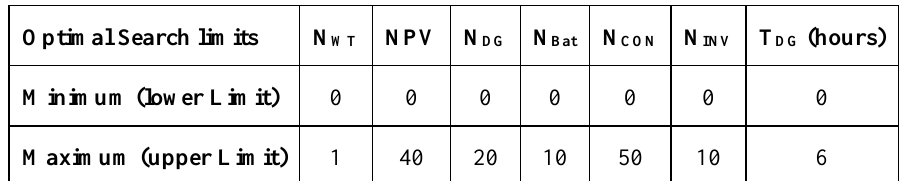
Table 7. Indicates the bounds and size of design variables